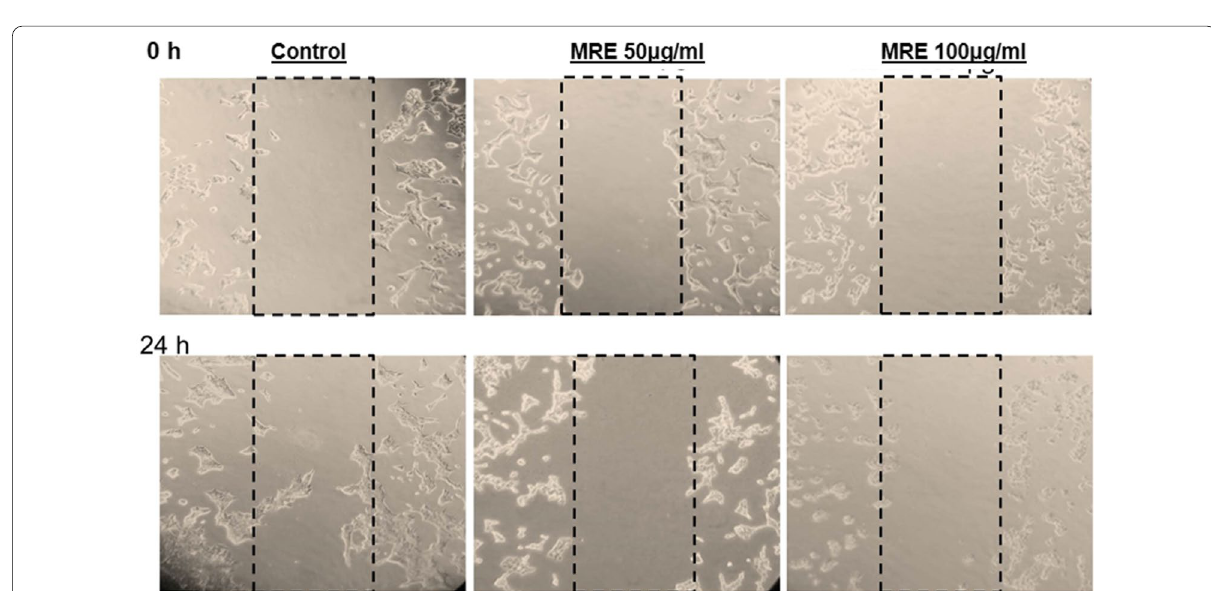
Fig. 4 Mangosteen rind extract (MRE)-dependent control of migration of MCF-7 cells. MCF-7 cells were treated with MRE (0, 50, and 100 μg/ml) and the effect of MRE on migration of MCF-7 cells were analyzed by scratch blot assay. Status of cell migration after 24 h of treatment were observed under light microscope at 20X